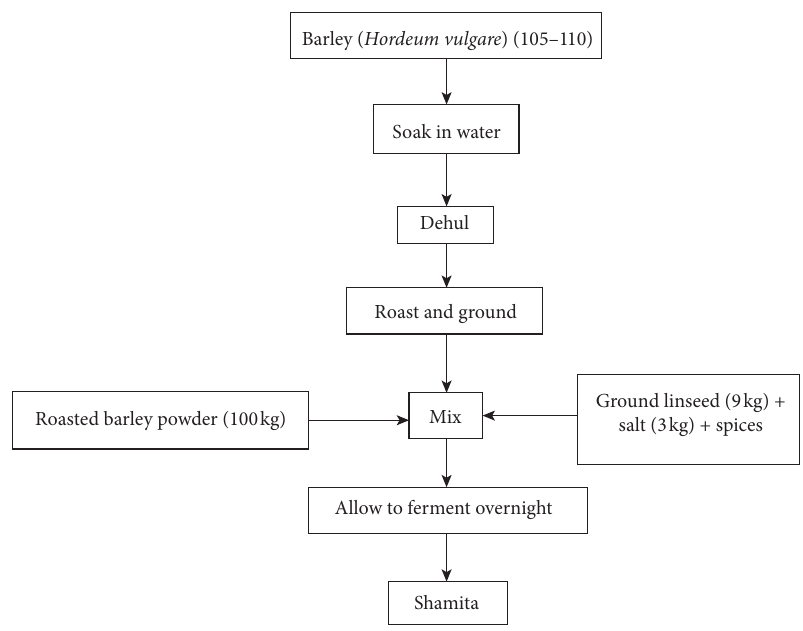
Figure 4: Flow chart of the Shamita production process by [2]. Table 2: Experimental results of pH and ethanol level of Ethiopian traditional alcoholic drinks,